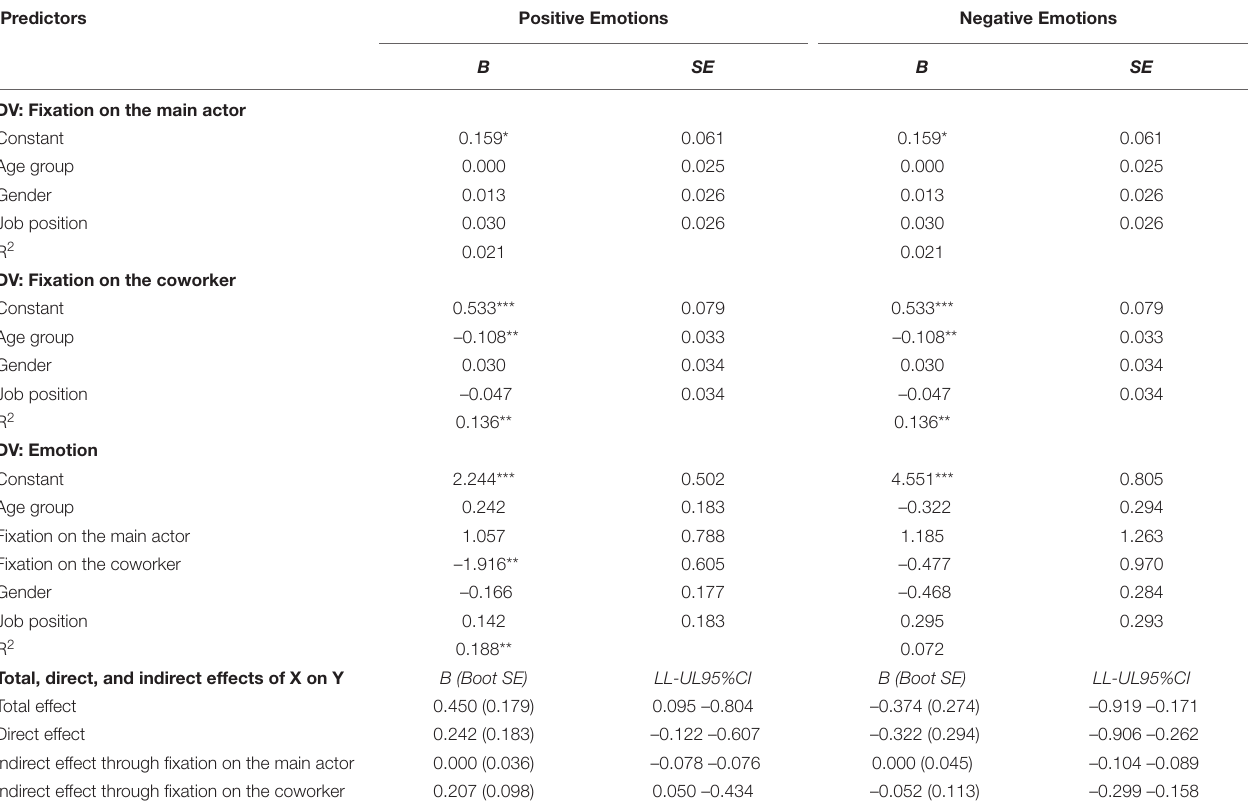
TABLE 2 | Results of the indirect effect of age group on emotional responses and conflict strategies to intergenerational conflict through visual fixation.